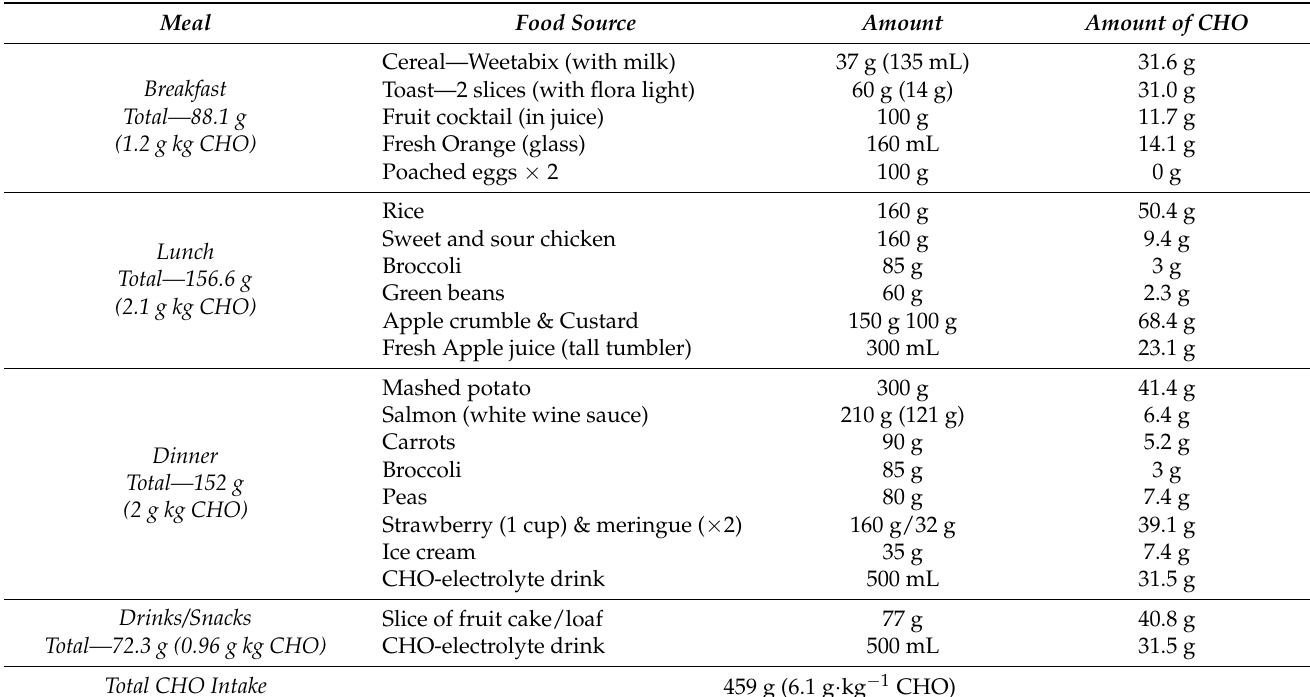
Table 2. Potential meal ideas to achieve 6 g · kg for a 75 kg player on MD-1. Data analysed with nutritional management software Nutritics (Dublin,